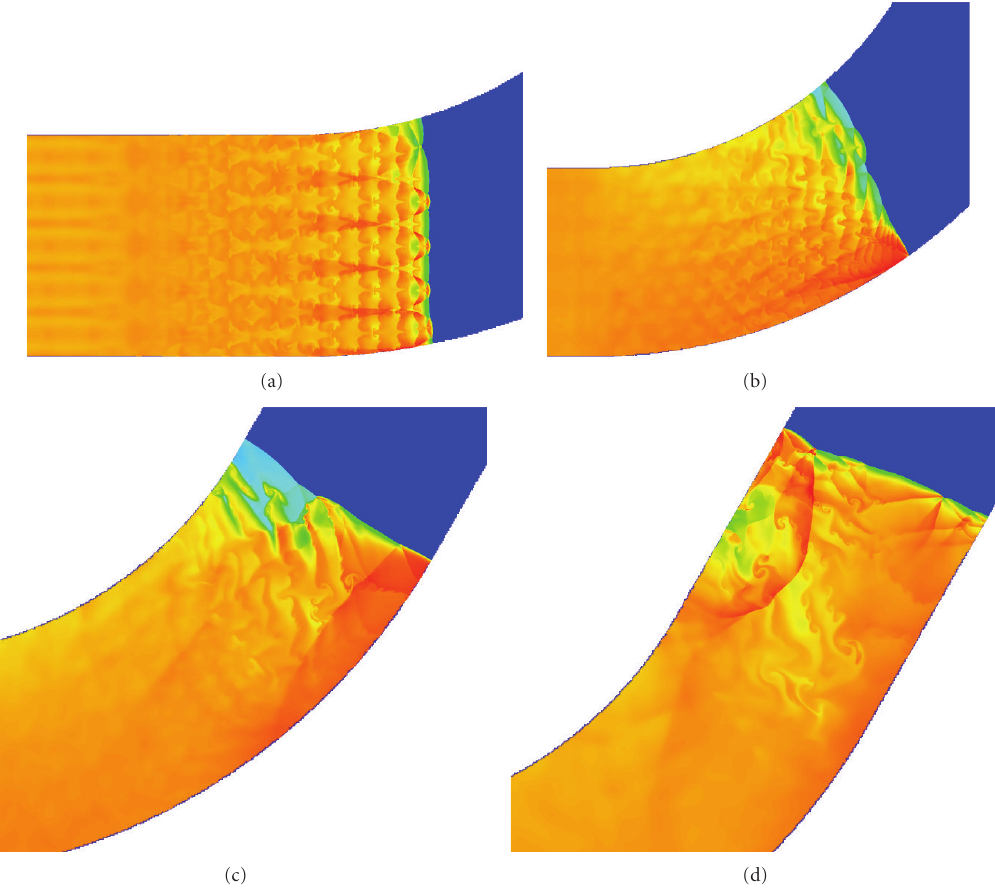
Figure 21: Color plots of the temperature for the regular oscillating hydrogen-oxygen detonation propagating upwards a pipe bend of width 5 λ . Snapshots are taken in 50 μ s intervals and start at t = 100 μ s